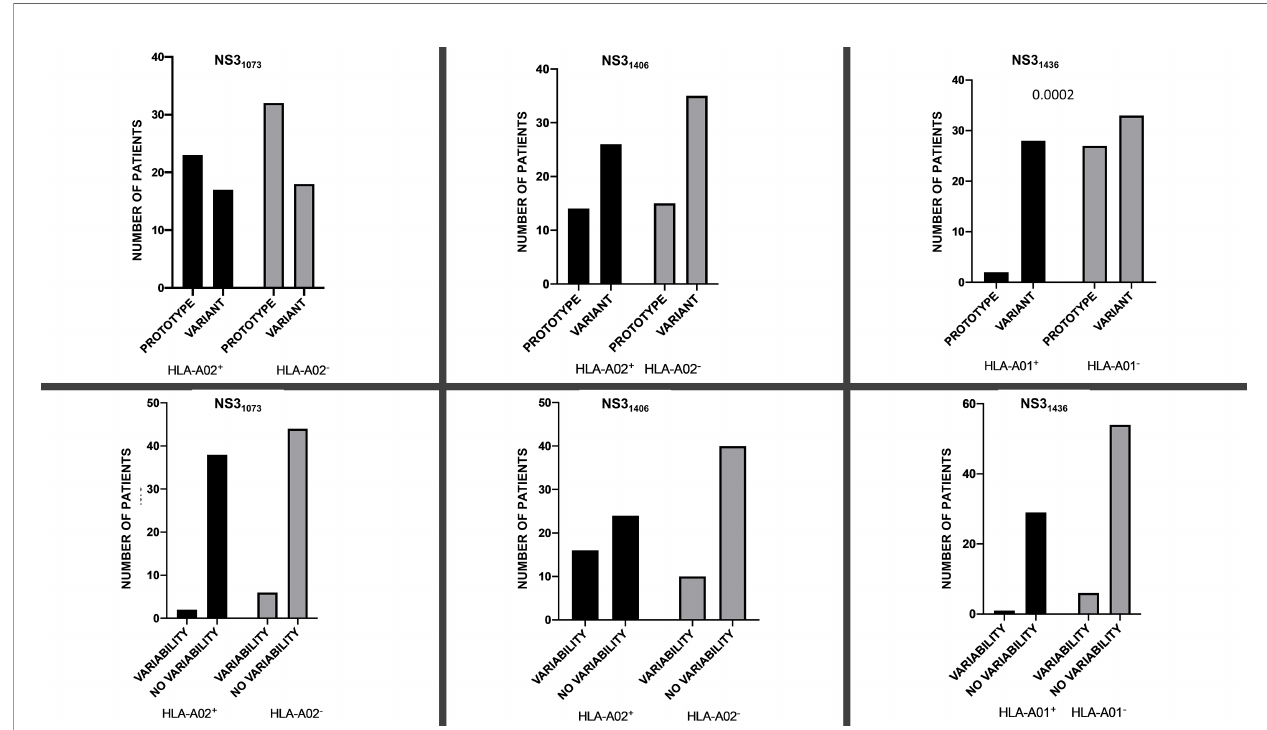
FIGURE 1 | Prevalence of prototype 1b (GenBank EU255962.1) variant (upper panel) dominant sequence and presence/absence of variability ( i.e. , ≥ 2 variants) (lower panel) for NS3 1073 , NS3 1406 and NS3 1436 epitopes in the context of the restricting HLA-A*01/HLA-A*02